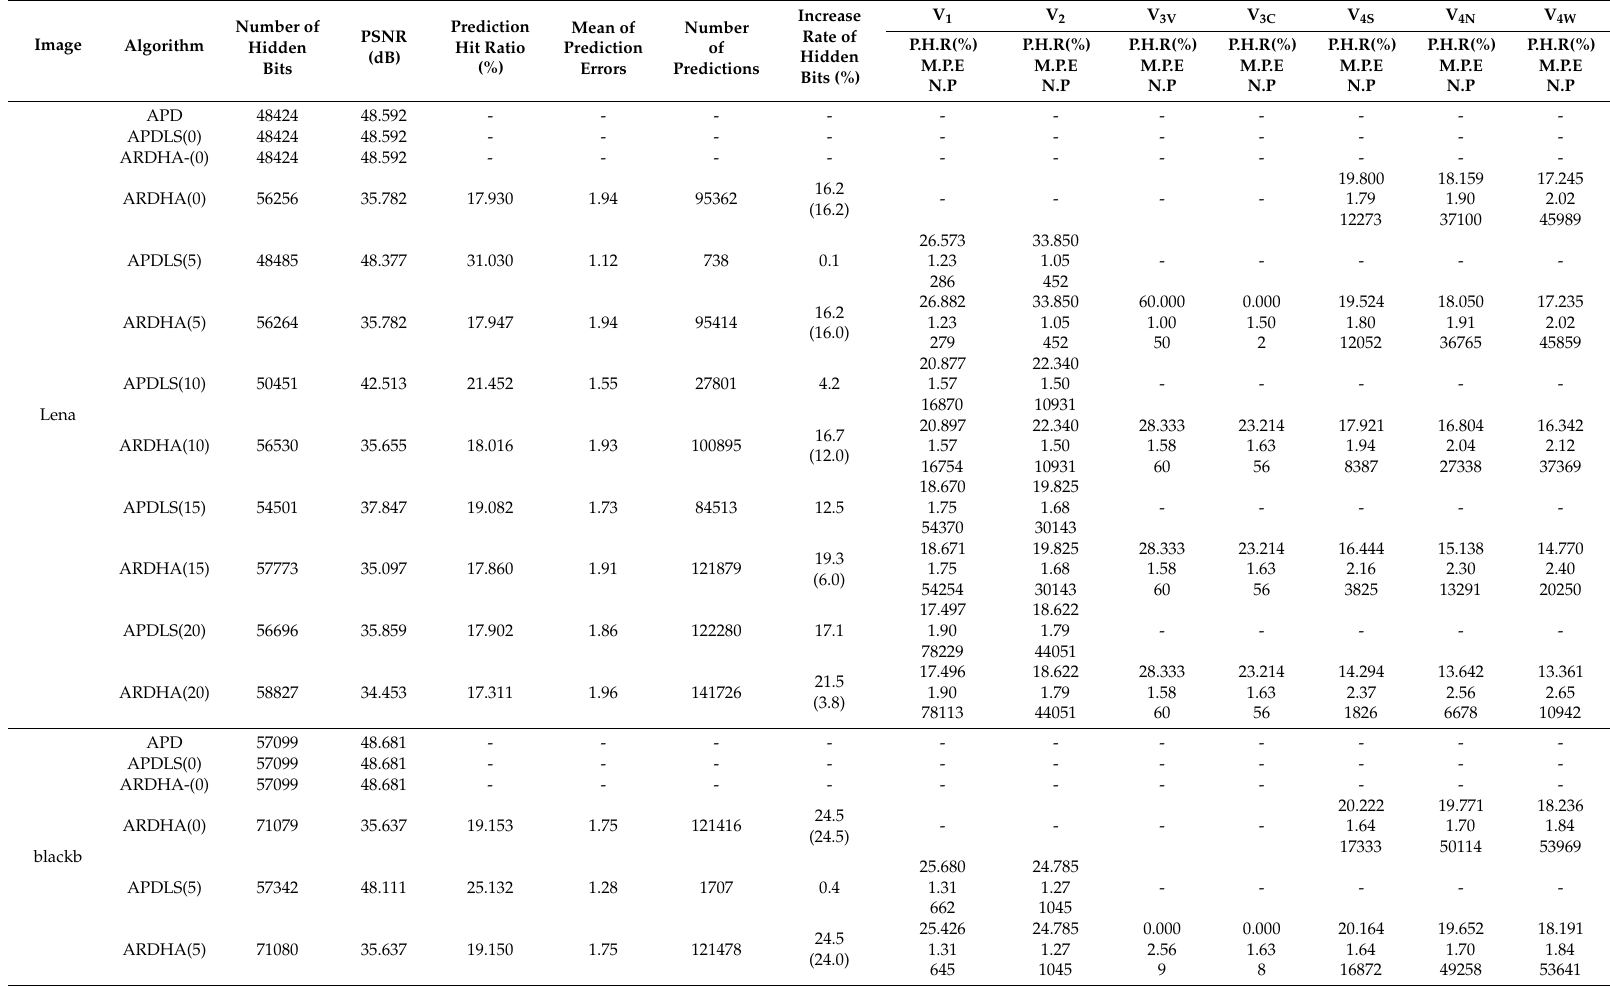
Table 1. Experimental